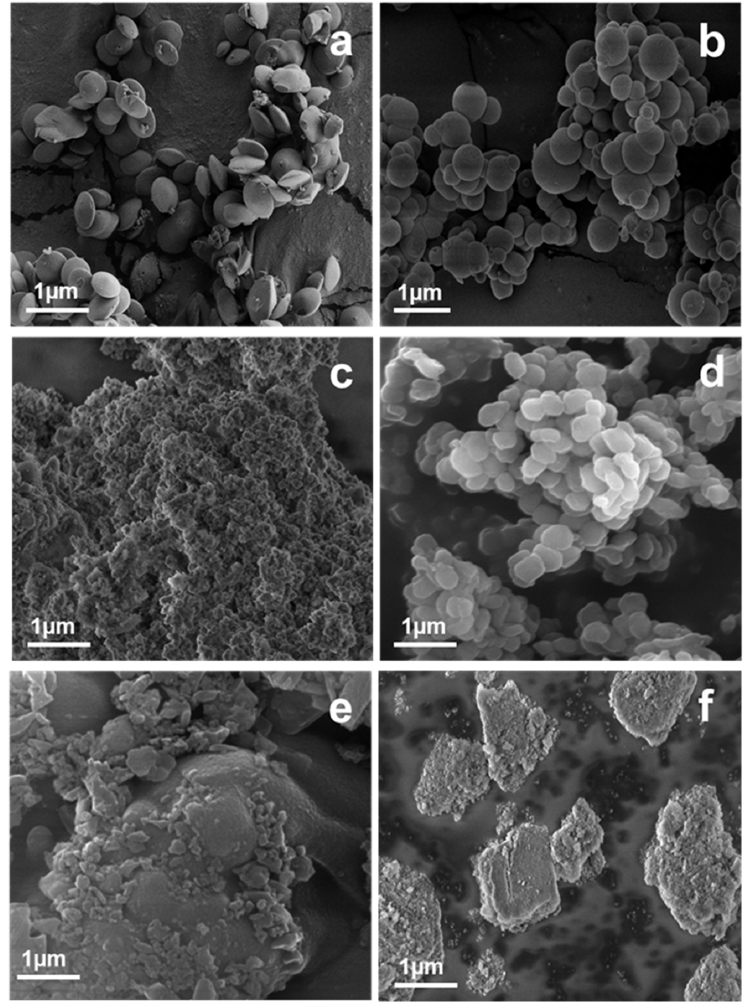
Figure 2. SEM images of MSNs: MCM-41(HO) ( a ); MCM-41(S) ( b ); MCM-48 ( c ); SBA-15 ( d ); PHTS ( e ) and MCF ( f ).